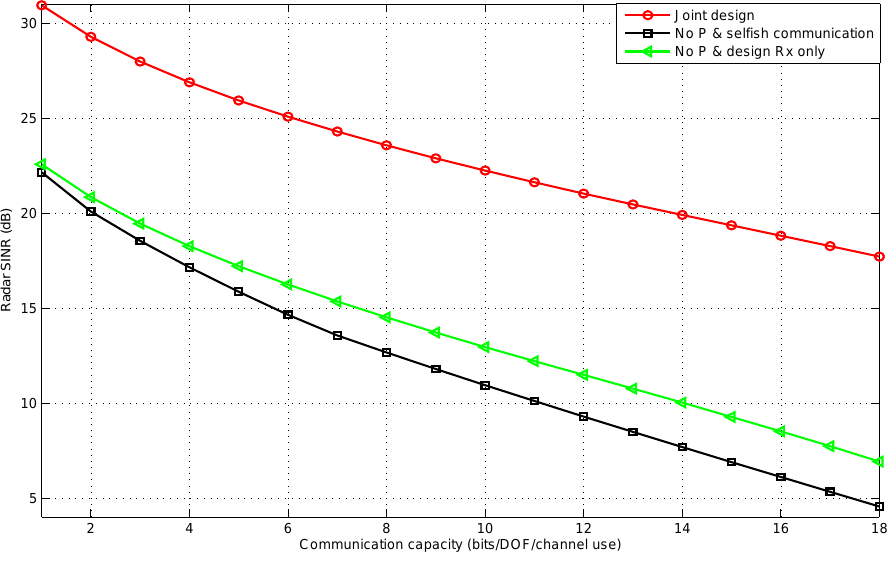
Figure 3. Radar SINR under different communication capacity (QoS)